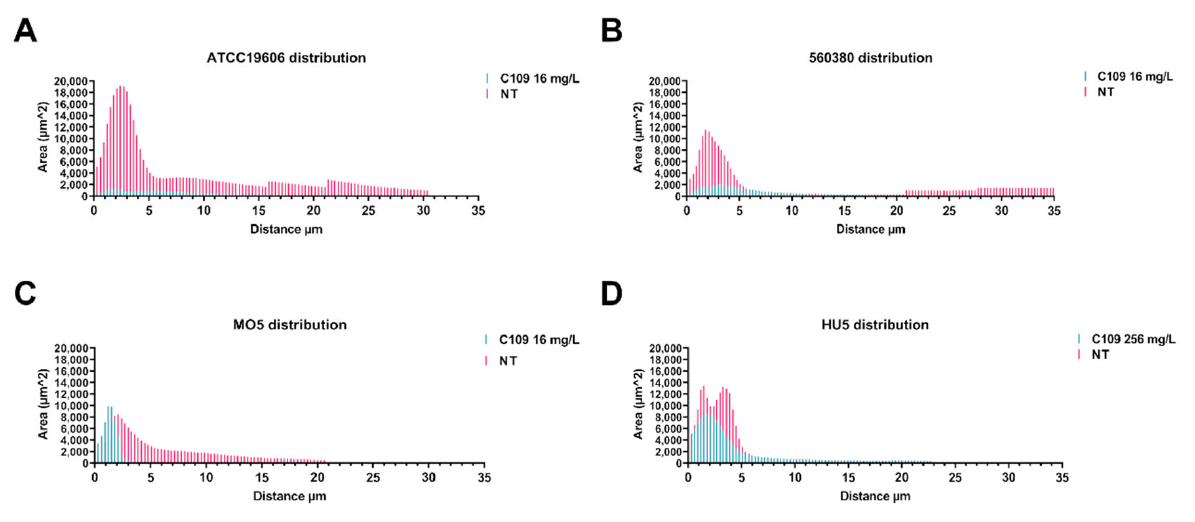
Figure 6. Analysis of biofilm properties by COMSTAT 2% of the area occupied by biofilm distribution, ( A ) ATCC19606, ( B ) 560380, ( C ) MO5 and ( D ) HU5. Data are the mean ± SD of the results from three independent replicates.